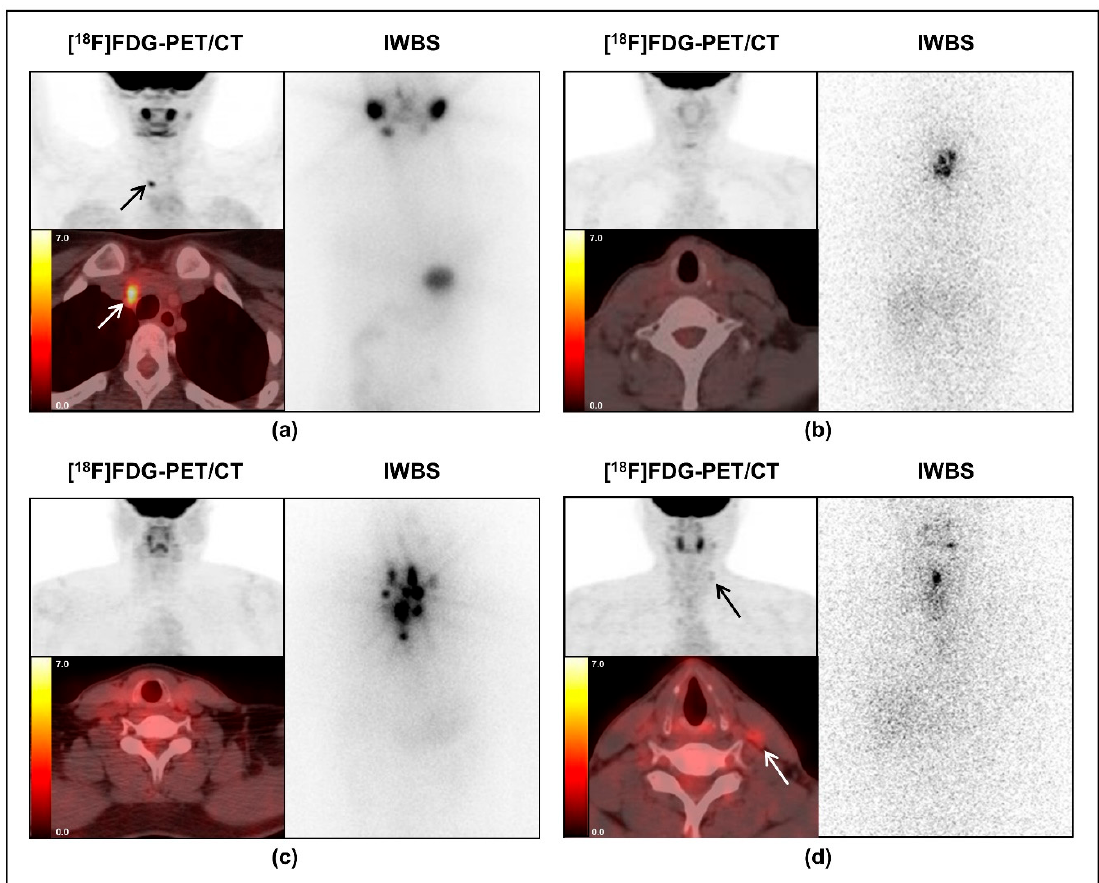
Figure 4. Differences in the diagnostic performance of PET/CT for detecting FDG-avid persistent disease (PD) based on the metastatic lymph node ratio (LNR)-combined criteria, and comparison with post-therapeutic iodine-whole-body scan (IWBS) in patients with papillary thyroid cancer (PTC). ( a ) An 18-year-old woman with a high central LNR (CLNR) of 1.00 was indicated for [ 18 F]FDG-PET/CT because the serum thyroglobulin level immediately before RAI therapy (D0Tg, 16.0 ng/mL) was above the cut-off value ( ≥ 7.5 ng/mL). This patient had focal FDG uptake at the right neck level VI (black and white arrows, SUVmax: 4.9), which was pathologically revealed as PD. There was no significant iodine uptake in the thyroidectomy bed or in the midline neck area on IWBS. ( b ) A 46-year-old woman with a low CLNR of 0.16, which was less than the cut-off value (0.44), was not indicated for [ 18 F]FDG-PET/CT despite of a high D0Tg level (10.0 ng/mL). This patient had no FDG-avid PD on PET/CT; however, several iodine uptake areas were observed in the anterior neck on IWBS. ( c ) A 40-year-old man with a high CLNR of 1.00 was initially indicated for [ 18 F]FDG-PET/CT because of a high serum D0Tg level (21.0 ng/mL) according to the criteria. However, there was no FDG-avid PD on PET/CT. Instead, there were multiple iodine uptake areas in the anterior neck on IWBS. ( d ) A 29-year-old man with a high CLNR of 0.53 had FDG-avid PD at the left neck level III (black and white arrows, SUVmax: 2.9), although he was not indicated for [ 18 F]FDG-PET/CT because of a low D0Tg level (1.0 ng/mL). An IWBS showed iodine uptake only in the midline of the anterior neck. (IWBS, iodine-whole-body